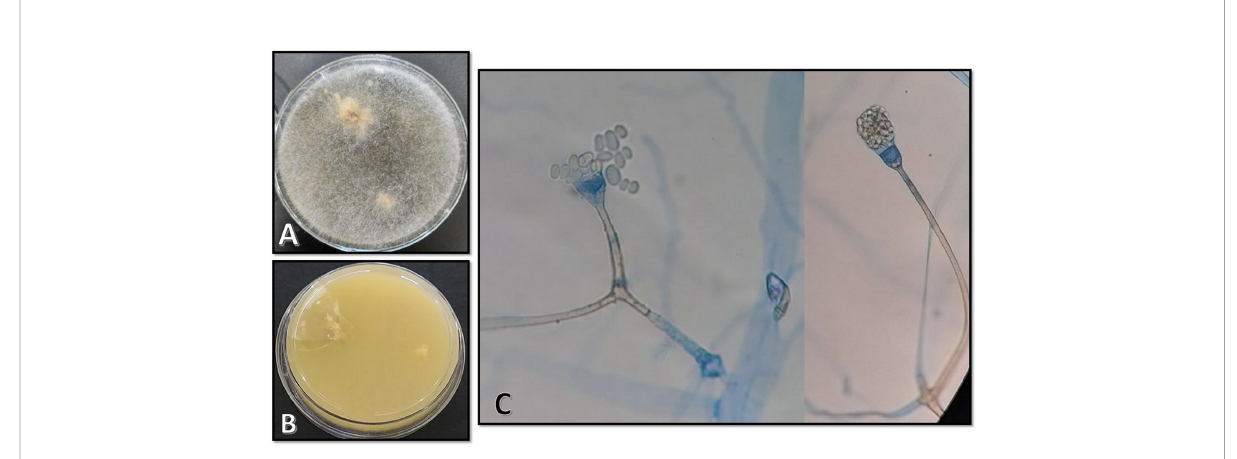
FIGURE 3 (A, B) Morphological characteristics of colonies on Sabouraud dextrose agar on the surface and the reverse after 4 days of incubation at 25°C. (C) Microscopic appearance of the isolate as observed on a slide prepared from the fungal